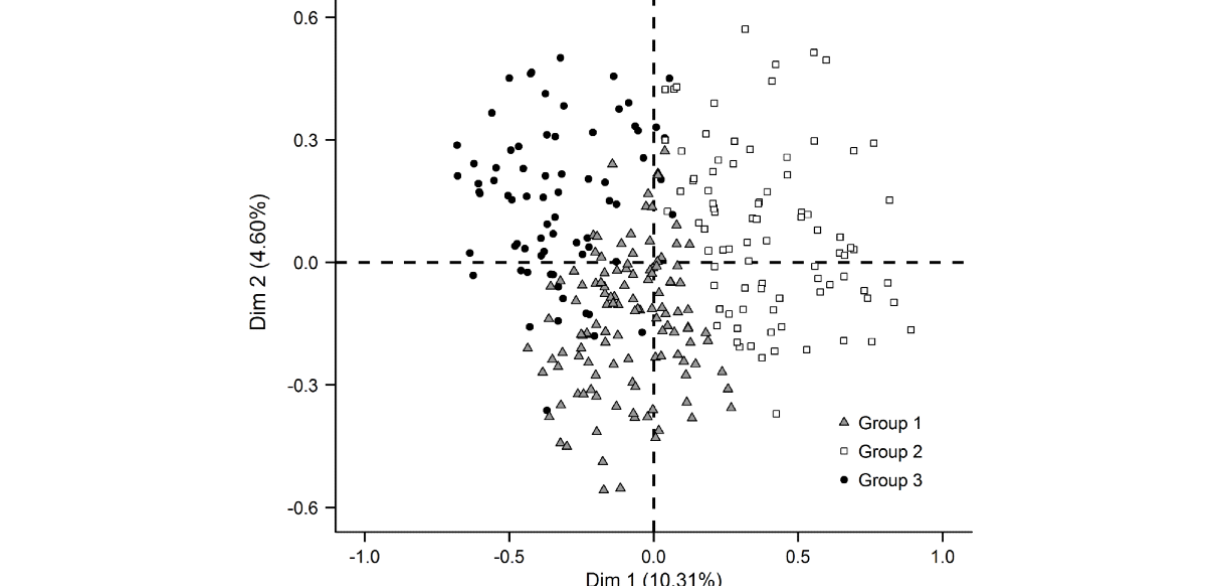
Figure 2. Factorial analysis of people living with HIV by sociodemographic and medical characteristics, and their answers to 113 questions concerning eHealth: searching for information on the internet and social media, collection of digitized personal information, and mHealth apps and connected objects for